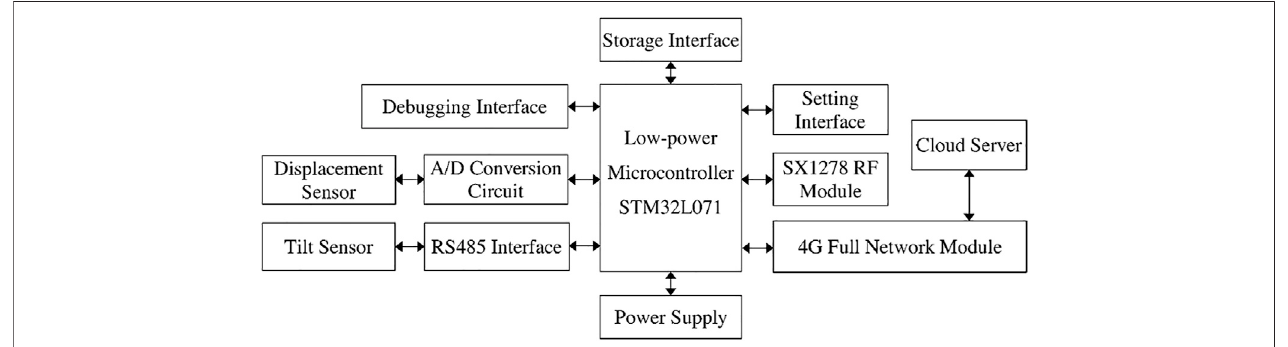
FIGURE 8 | Structure diagram of gateway master-node.